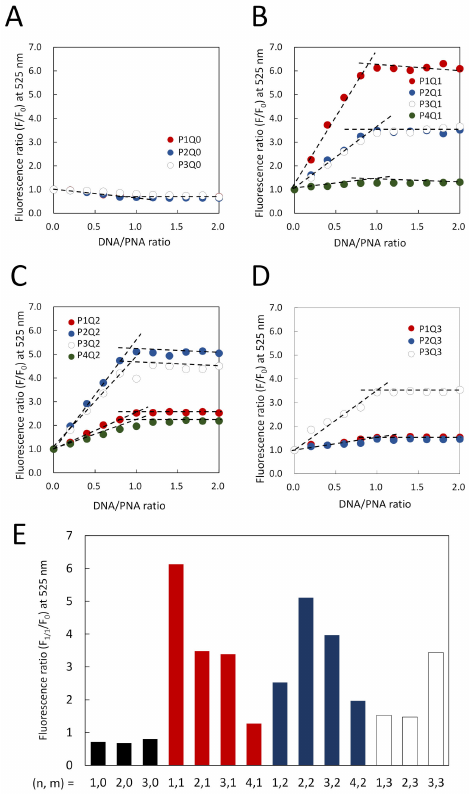
Figure 5. Titration curves of fluorescence intensities at 525 nm for: ( A ) PnQ0 (n = 1–3); ( B ) PnQ1 (n = 1–4); ( C ) PnQ2 (n = 1–4); and ( D ) PnQ3 (n = 1–3), with fmDNA. ( E ) Fluorescence ratios (F 1/1 /F 0 ) of the 1:1 mixtures of PnQm and